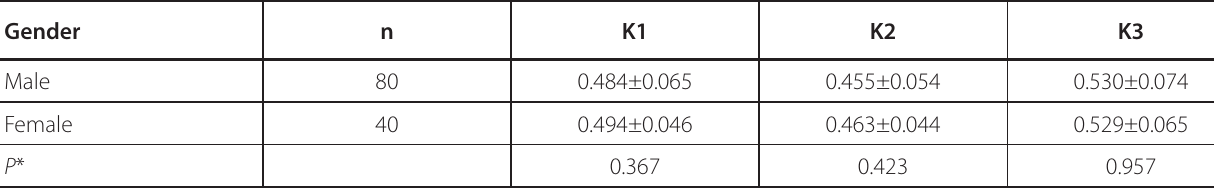
Table 2 . Comparison of K between gender groups.